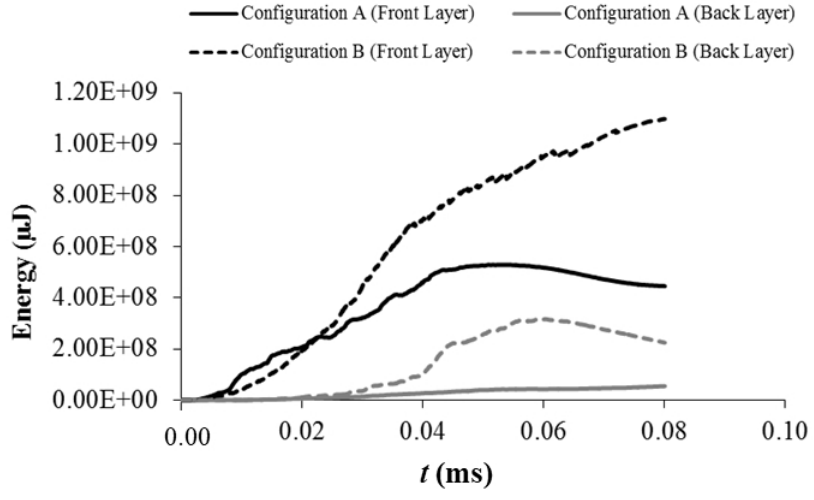
Figure 15. Energy absorbed by front and back layers of each plate at initial velocity of 800 m/s.